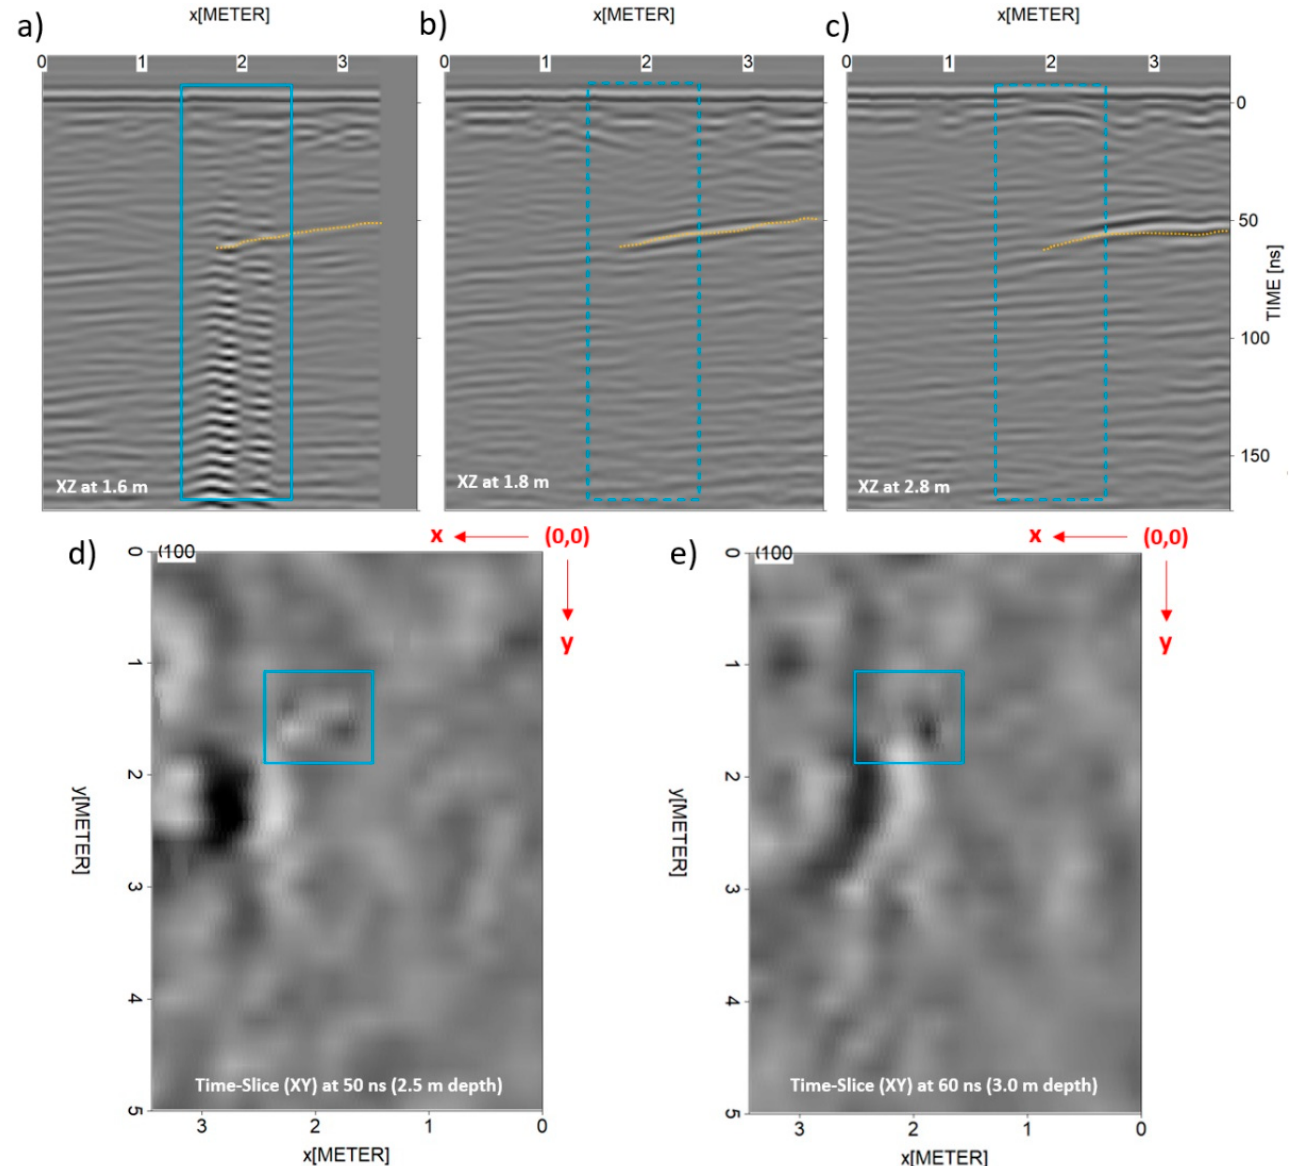
Figure 7. 200 MHz data showing the spatial correlation between the springs’ surging and a probable fractured zone detected: XZ image at 1.6 m in y -line ( a ), XZ image at 1.8 m in y -line ( b ), XZ image at 2.8 m in y -line ( c ), time-slice or XY image at 2.5 m depth ( d ), and time-slice or XY image at 3.0 m depth ( e ).